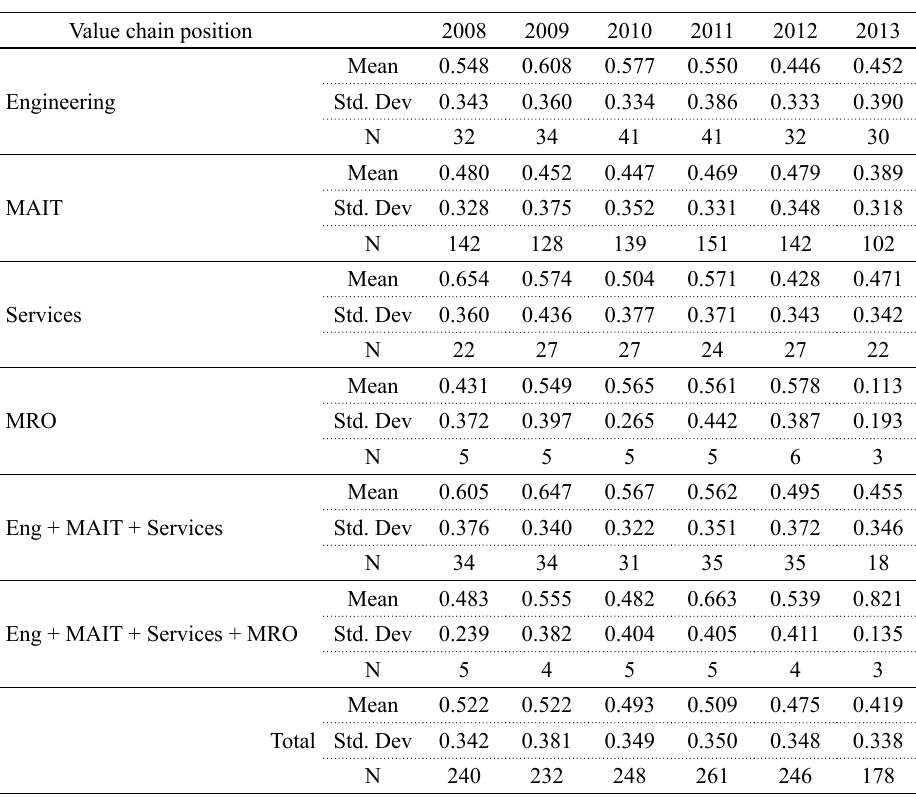
Table 3. Financial performance of Spanish aerospace companies segmented by value chain position Value chain position